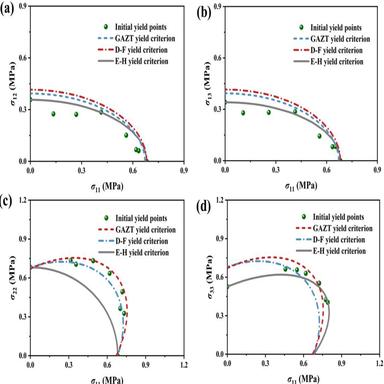
Comparisons between the yield points and three typical theoretical yield models of SB lattice structures in different stress planes: (a) σ11 − σ12; (b) σ11 − σ13; (c) σ11 − σ22 and (d) σ11 − σ33.